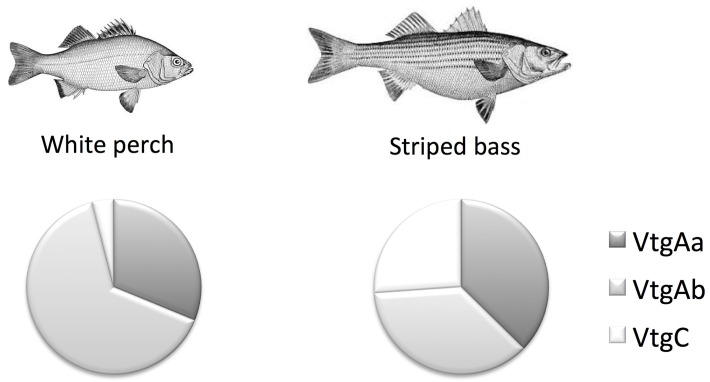
Vitellogenin composition in white perch and striped bass egg yolk.In white perch (M. americana), yolk proteins derived from VtgC are minor components of the total egg yolk (< 5%), whereas in striped bass (M. saxatilis) they are major components of the egg yolk (~ 25%). [Williams et al., 2014 (J Exp Zool Part A); Schilling et al., 2014 (J Proteome Res)].